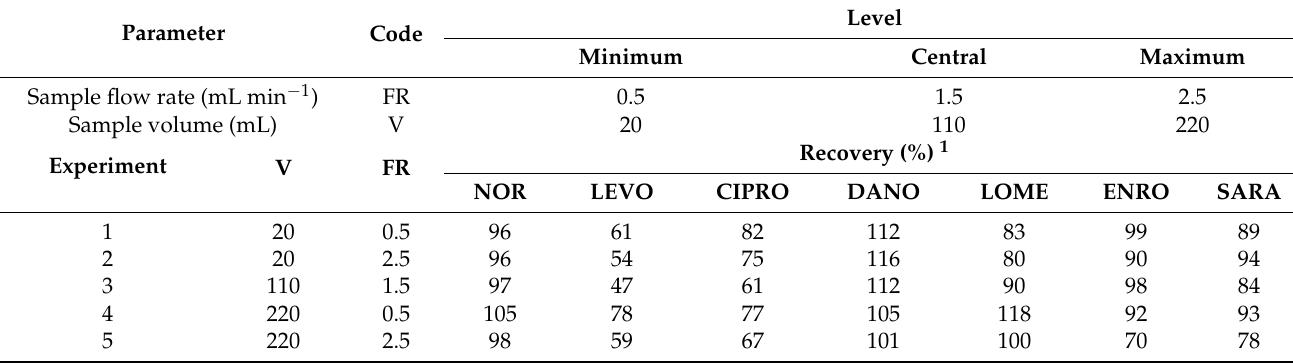
Table 2. Experimental domain and two-level factorial